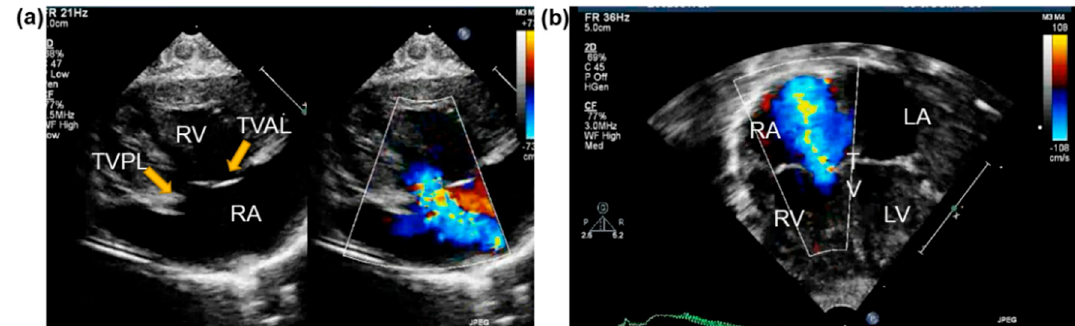
Figure 5. Visualization of severe tricuspid reguritation using two different 2DTTE views and color flow Doppler: ( a ) a parasternal long-axis inflow view, and ( b ) an apical four-chamber view of a newborn with a severe pulmonary hypertension due to diaphragmatic hernia. Images courtesy of Dr. Mir and Dr. Burkhart from the Children’s Heart Center at the University of Oklahoma Health Sciences Center (OUHSC).